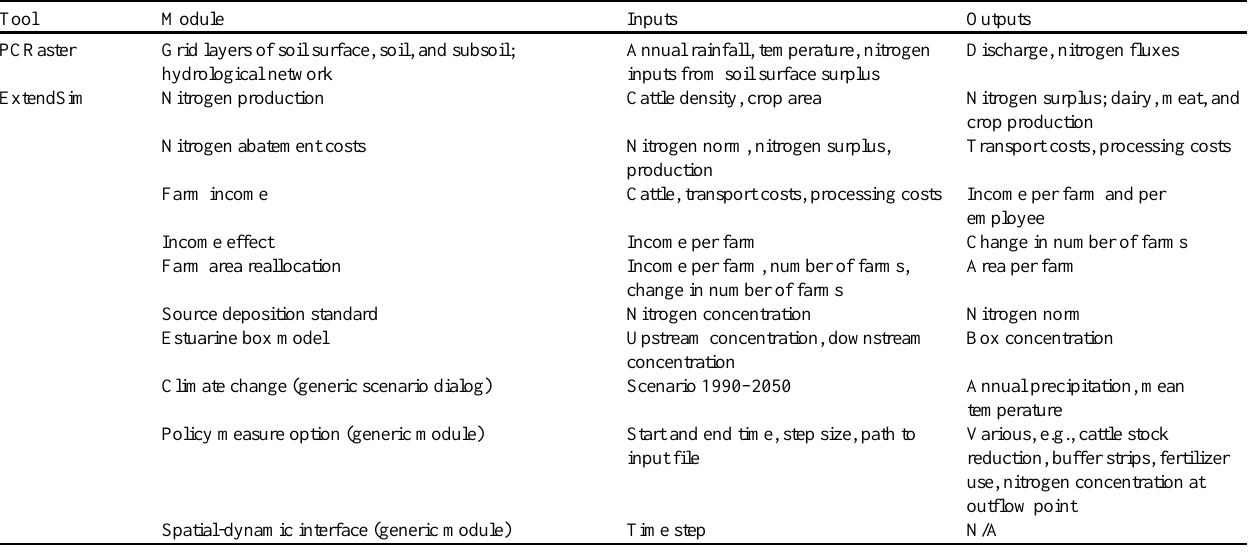
Table 2. Model suite modules and their main components, inputs, and